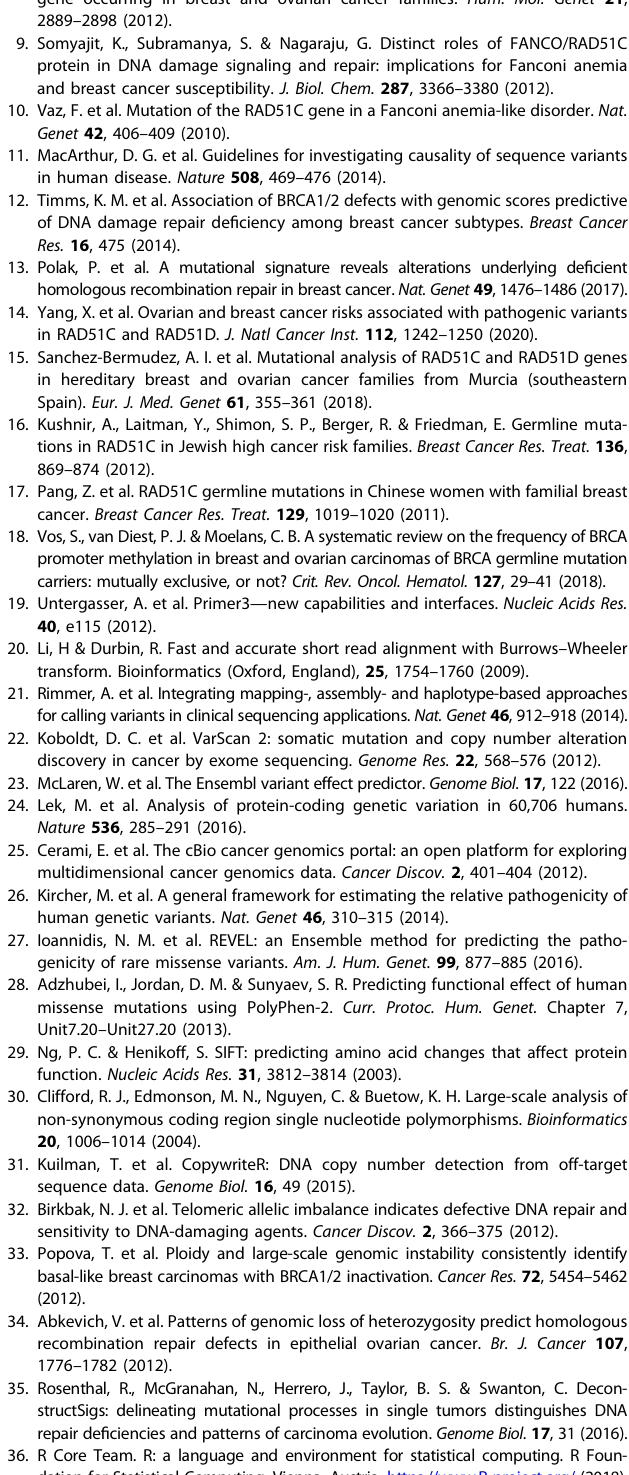
structSigs: delineating mutational processes in single tumors distinguishes DNA repair de fi ciencies and patterns of carcinoma evolution. Genome Biol. 17 , 31 (2016). 36. R Core Team. R: a language and environment for statistical computing. R Foun- dation for Statistical Computing, Vienna, Austria. https://www.R-project.org/